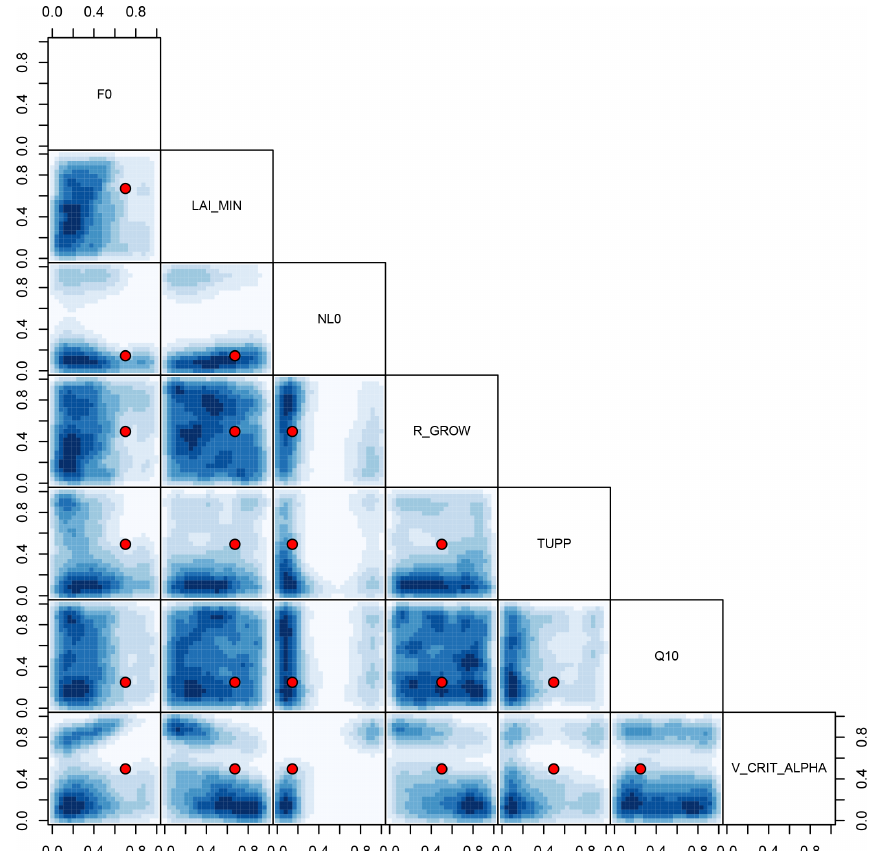
Figure 16. Two-dimensional projections of the density of inputs where the corresponding bias-corrected emulated forests have a smaller error than the bias-corrected default parameters. These regions might be good targets for additional runs of the climate model. Default parameters are shown as a red